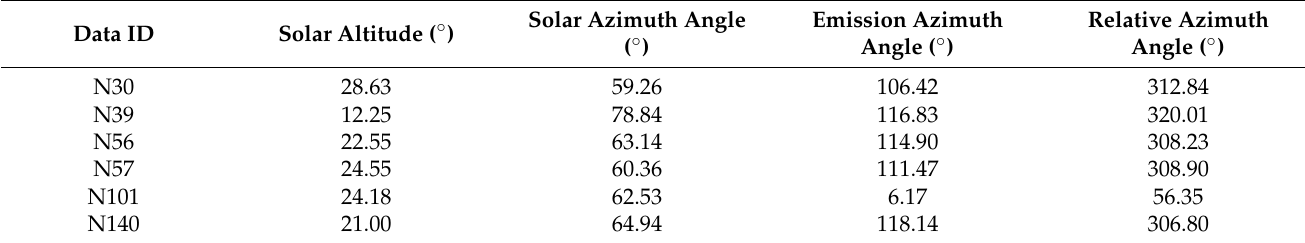
Figure 6. Radiance images of the lunar surface observed by the Yutu-2 rover at 750 nm, affected by shadows. All the images are stretched from 0 to 0.05 to illustrate the albedo variation. ( a – f ) correspond to image IDs N30, N39, N56, N57, N101 and N140, respectively. Table 1. Observation angles of data affected by